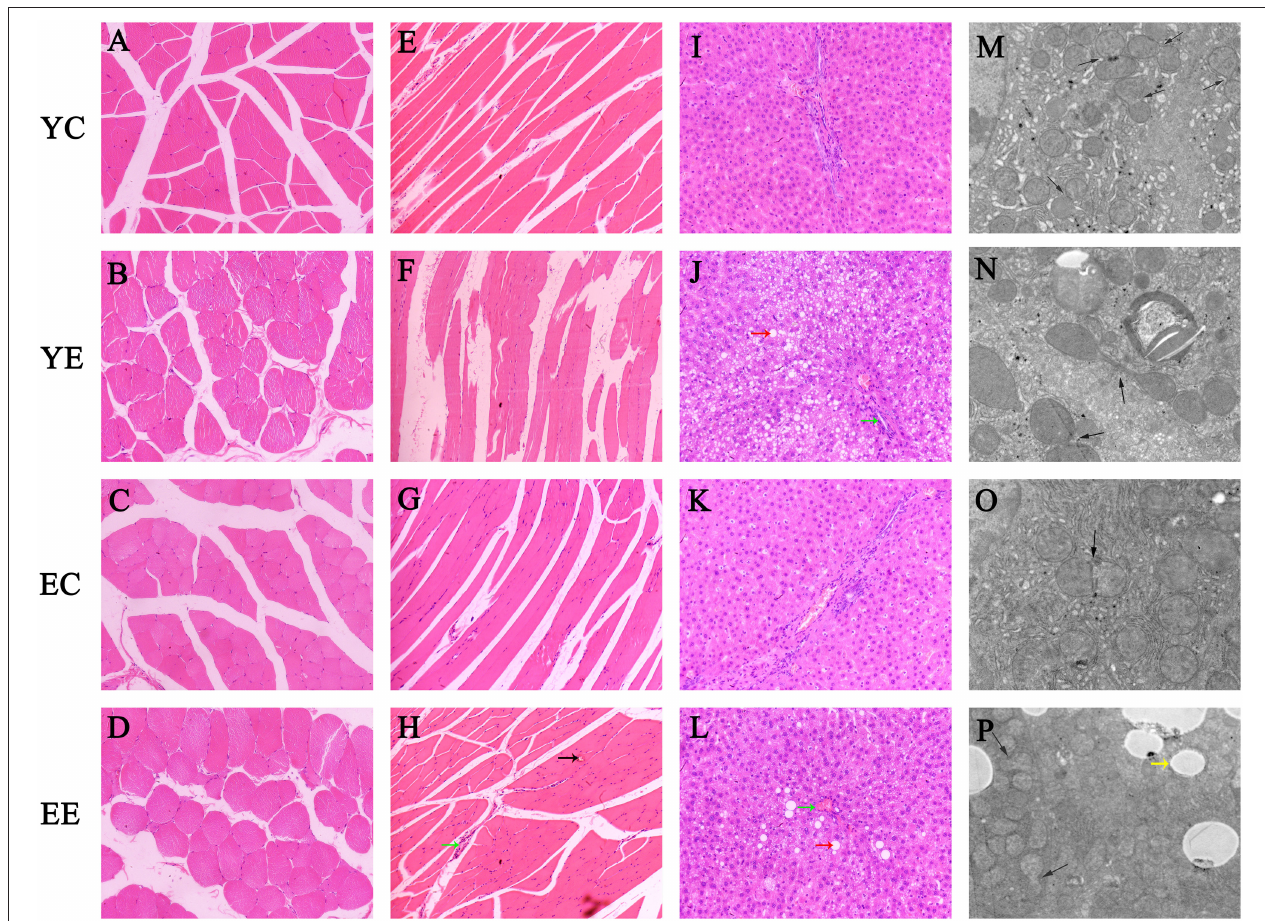
FIGURE 4 | Hematoxylin–eosin staining of transverse (A–D) and longitudinal (E–H) sections of skeletal muscle. (I–L) Hematoxylin–eosin staining of liver tissue. (Green arrow: inflammatory cell infiltration; red arrow: vacuolar degeneration; black arrow: bleeding point). Original magnification: × 200. (M–P) Hepatic mitochondrial changes in each group’s rats. Bar = 5.0um. (Yellow arrow: white fat droplet). Mitochondrial fission and fusion were evaluated with an inverted fluorescence microscope (Eclipse Ts2, Nikon,